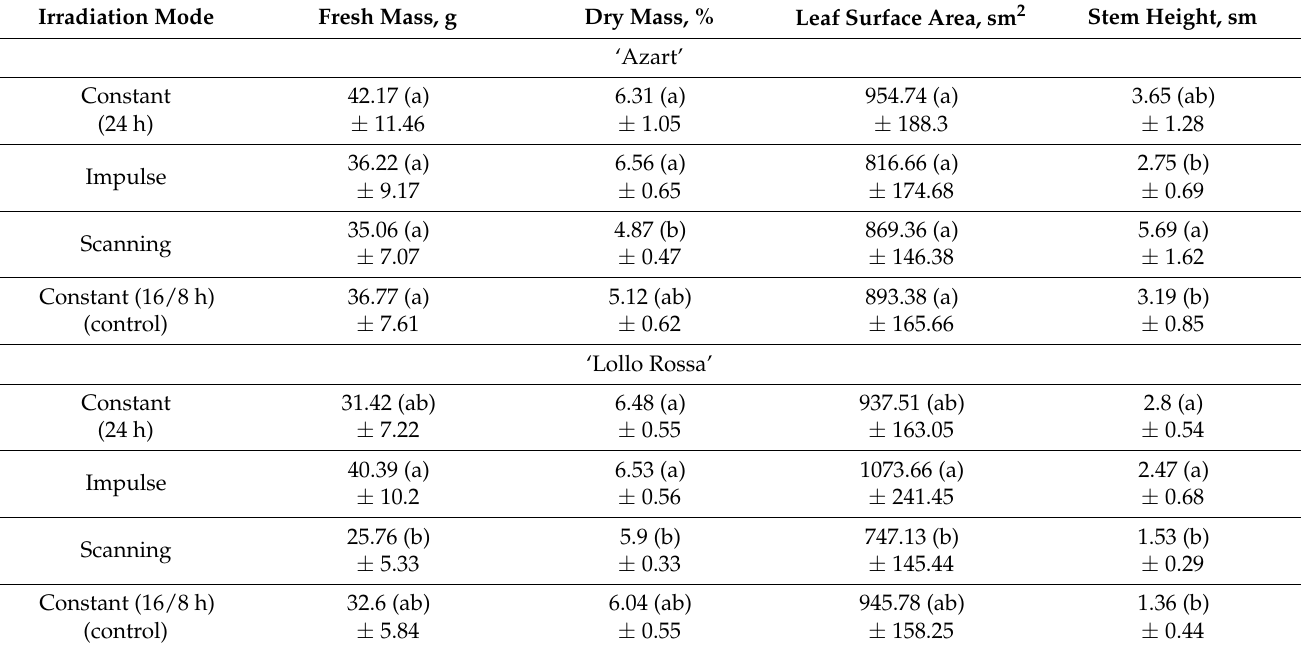
Table 1. Morphological parameters of lettuce plant of ‘Azart’ and ‘Lollo Rossa’ varieties on the 35th day of cultivation. Values represent mean SEM (n = 10). Letters indicate significant differences among treatment and control samples ( p <